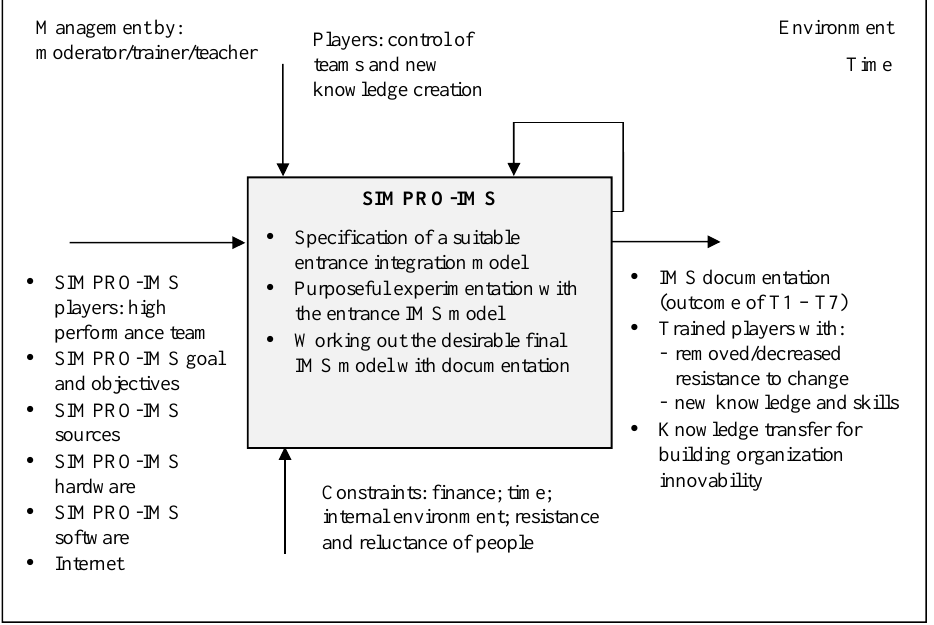
Figure 2 – Basic illustration of the SIMPRO-IMS